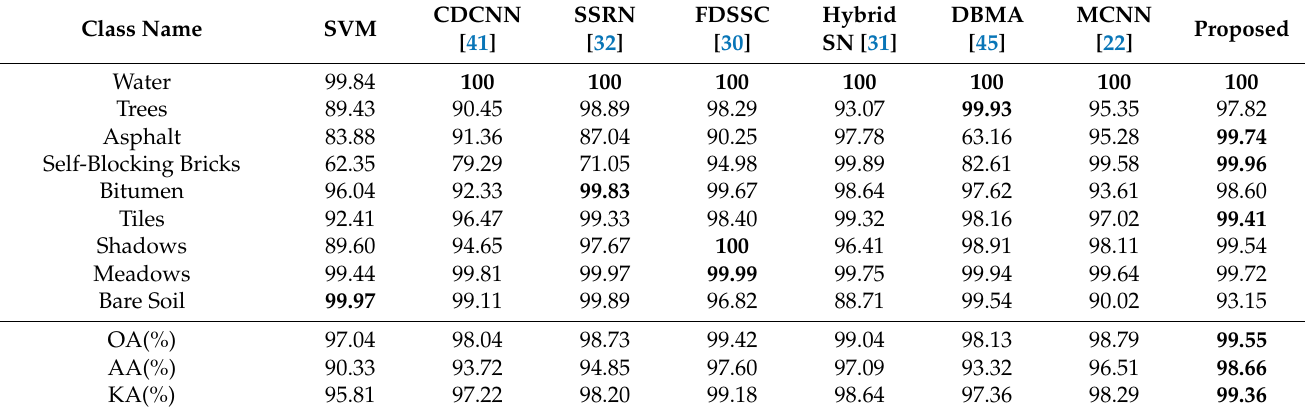
Table 6. Classification results of different models on the PC dataset.